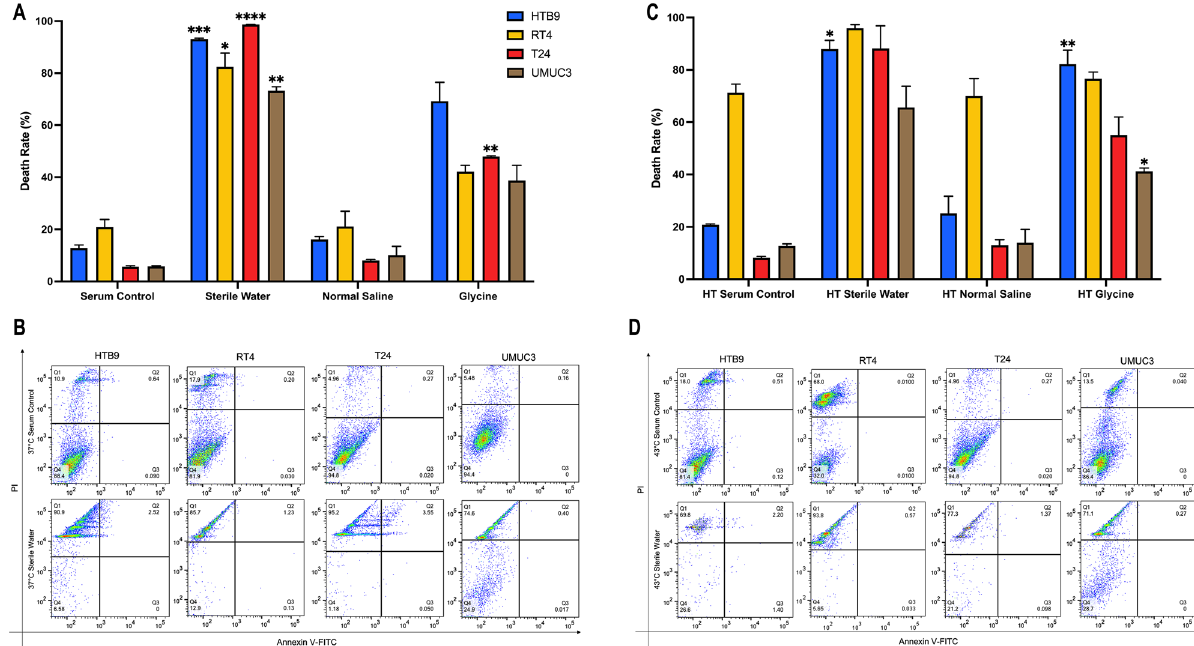
Figure 2. Death rates of bladder cancer cell lines analysed by flow cytometry after treating with different irrigation fluids. (A) HTB9, RT4, T24 and UMUC3 cell suspension were incubated in sterile water, normal saline or glycine at 37 °C for one hour. Percentages of death cells were estimated by FlowJo (version 10.4). (B) Representative flow cytometric charts of HTB9, RT4, T24 and UMUC3 incubated in serum control and sterile water at 37 °C for one hour. Cells at different conditions were populated at 4 quadrants. Q1-upper left: necrotic; Q2-upper right: late apoptosis; Q3-lower right: early apoptosis and Q4-lower left: viable. (C) HTB9, RT4, T24 and UMUC3 cell suspension were incubated in sterile water, normal saline or glycine at 43 °C for 1 h. Percentages of death cells were estimated by FlowJo (version 10.4). (D) Representative flow cytometric charts of HTB9, RT4, T24 and UMUC3 incubated in serum control and sterile water at 43 °C for one hour. Cells at different conditions were populated at 4 quadrants. Q1-upper left: necrotic; Q2-upper right: late apoptosis; Q3-lower right: early apoptosis and Q4-lower left: viable.Data are presented as the mean ± SD. Different strategies were compared with serum control of the same cell line. *p < 0.05 and **p < 0.01, ***p <